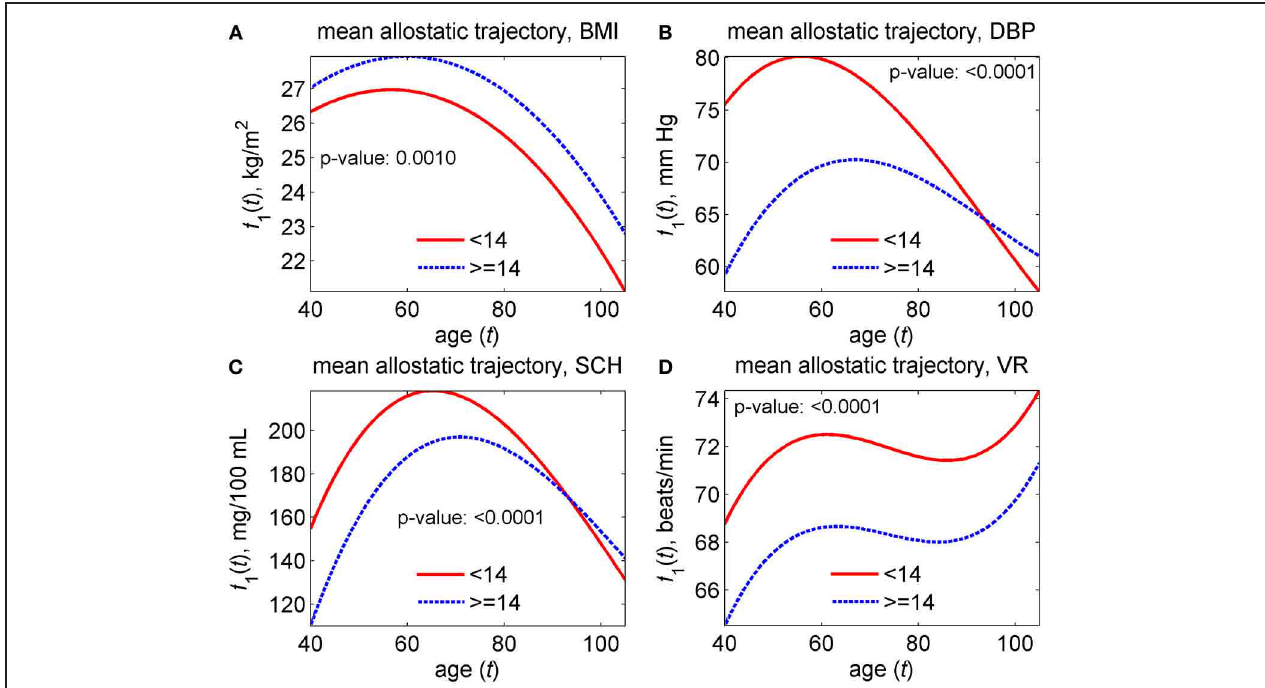
for body mass index (BMI); (B) estimates for diastolic blood pressure (DBP); (C) estimates for cholesterol (SCH); (D) estimates for ventricular rate (VR). P -values are for the null hypotheses on the equality of mean allostatic trajectories in the two groups. See more details about the model in section “Advanced statistical analyses using the stochastic process